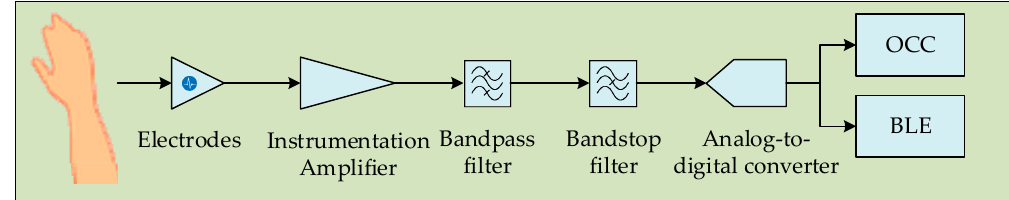
Figure 1. Data acquisition procedure from the patch. OCC: optical camera communication.